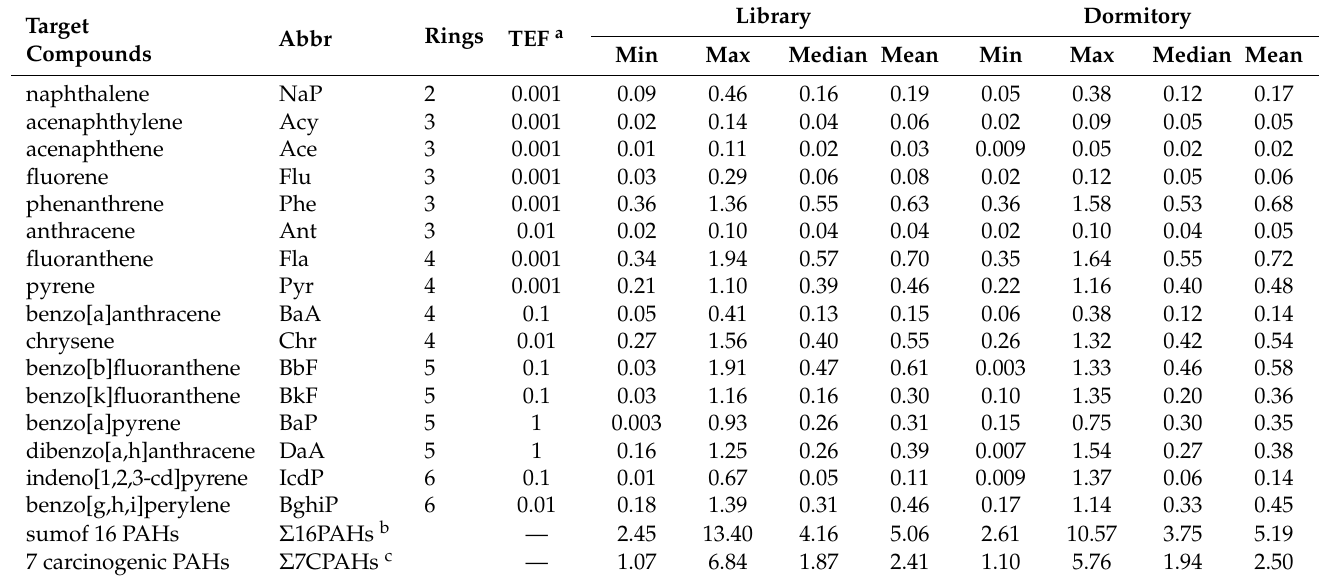
Table 1. PAHs concentrations ( µ g · g − 1 ) in atmospheric dustfall from the library and dormitory of Wuhan